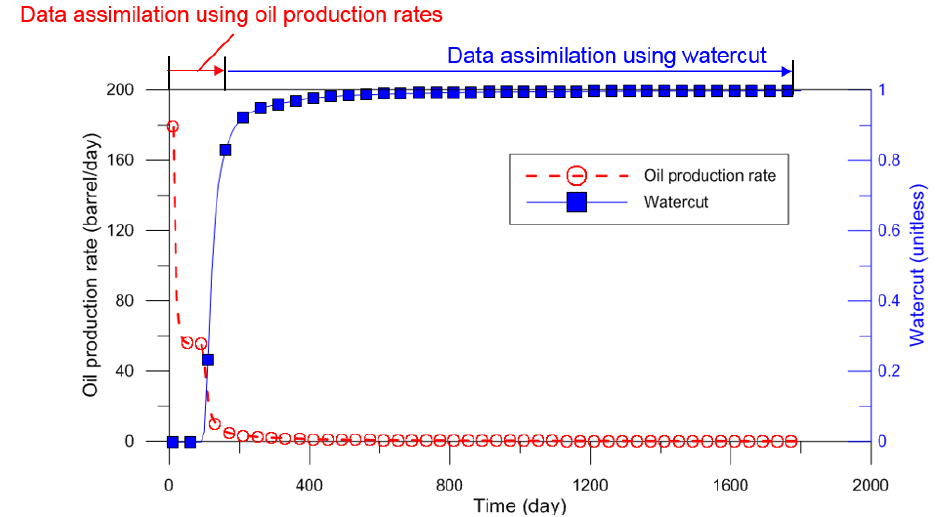
Figure 7. Example of selective usage of different observed data: As water breakthrough occurs, distinct separation of oil production rates from watercut is observed. Before the breakthrough, the oil production rates are the target of data assimilation; but after the water volume produced is significantly increased, the data assimilation should use watercut data, to obtain the reliability of ensemble-based methods.